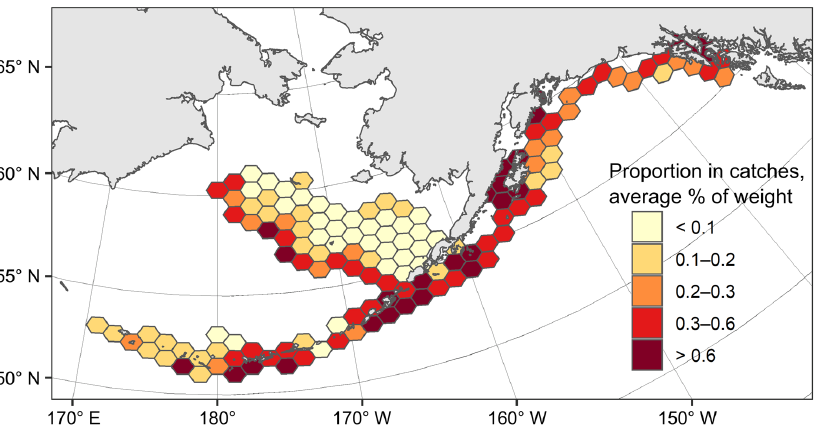
Figure 3. Distribution of catches (proportion in catches, % of weight) of the Aleutian skate Bathyraja aleutica in Alaskan waters in 1995–2021 according to data from American observers on board commercial fishing vessels.